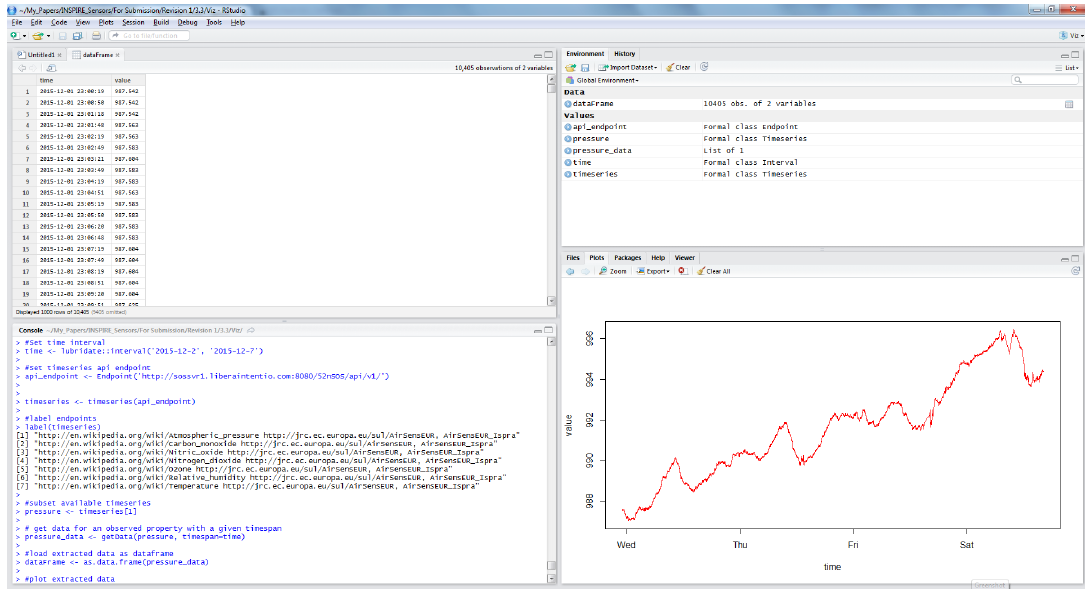
Figure 6. AirSensEUR data loaded and visualized in